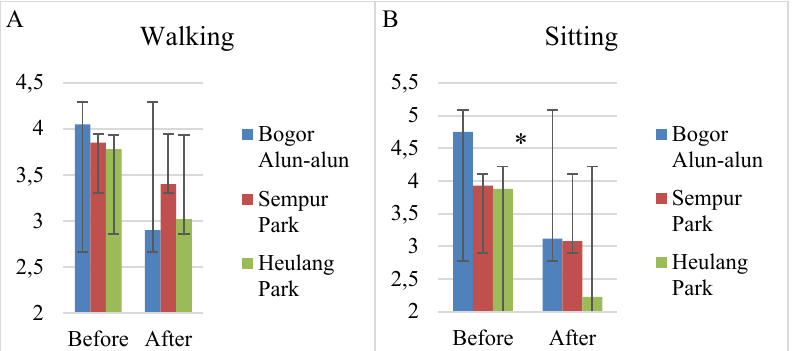
Figure 6. Comparison of the POMS (TMD) results in subscale walking and relaxed sitting before and after an experiment in the three locations. (A) Walking. (B) Relaxed sitting. Note: (*) p - value ≤0 .05